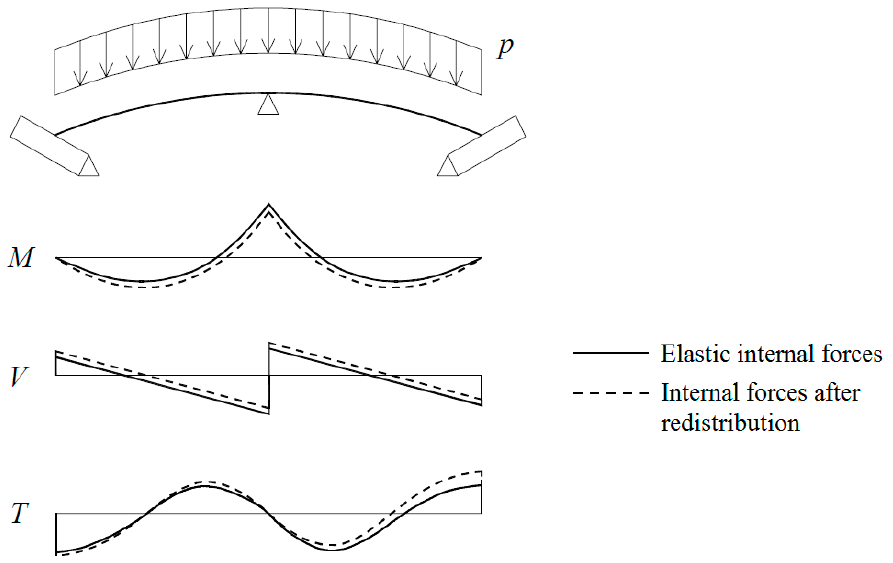
Figure 1. Curved continuous girder with two spans.